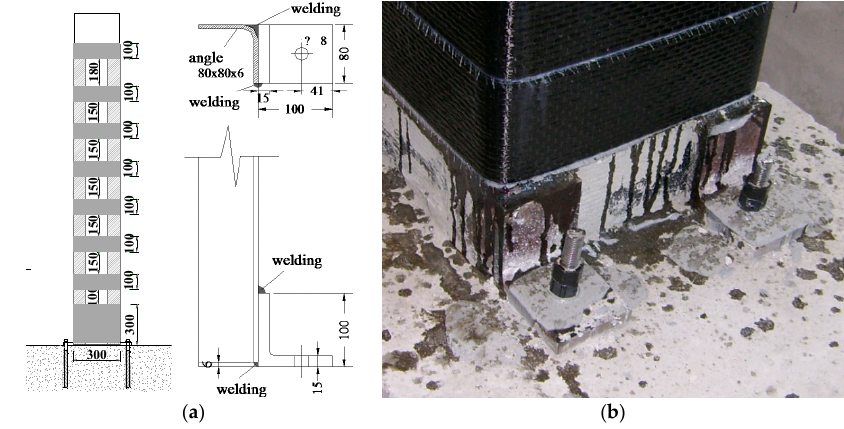
Figure 6. Strengthening systems “type A1” ( a ); details of steel profile’s anchorage system ( b ).